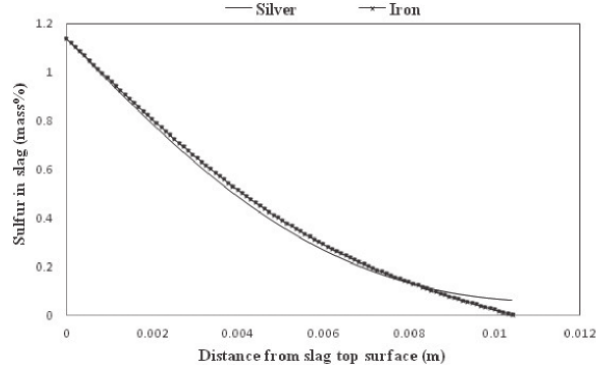
Fig. 5: Sulfur concentration variation in the slag phase when using silver and iron metal phases independently [21]. The right extreme represents the slag-metal